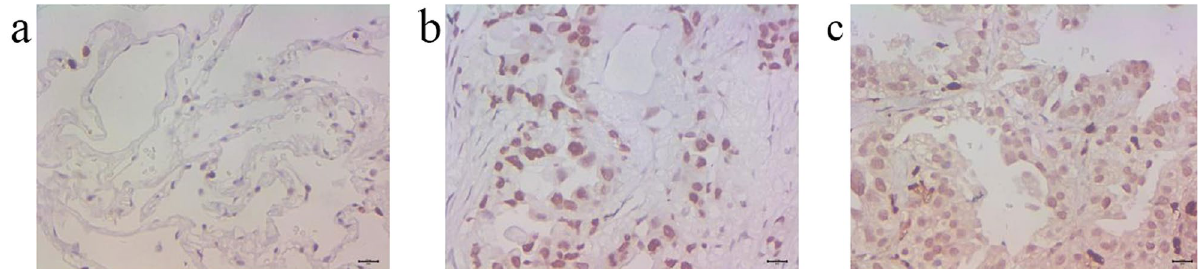
Figure 1. The tissue HIF-1 expression. ( a ) The negative HIF-1α expression of a normal lung tissue through immunohistochemical method (× 400). ( b ) The moderately positive HIF-1α expression of an EGFR-TKIs sensitive mutation NSCLC tissue through immunohistochemical method (× 400). ( c ) The strongly positive HIF-1α expression of EGFR-TKIs acquired resistant NSCLC tissue through immunohistochemical method (×